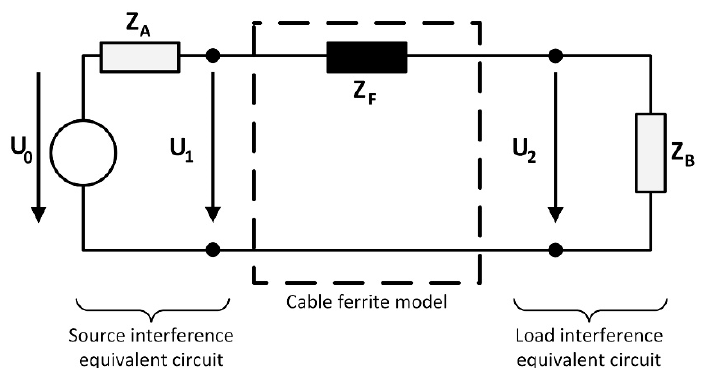
Figure 10. Diagram of source and load equivalents circuits used to determine the insertion loss parameter of a sleeve ferrite core when it is introduced into a system.